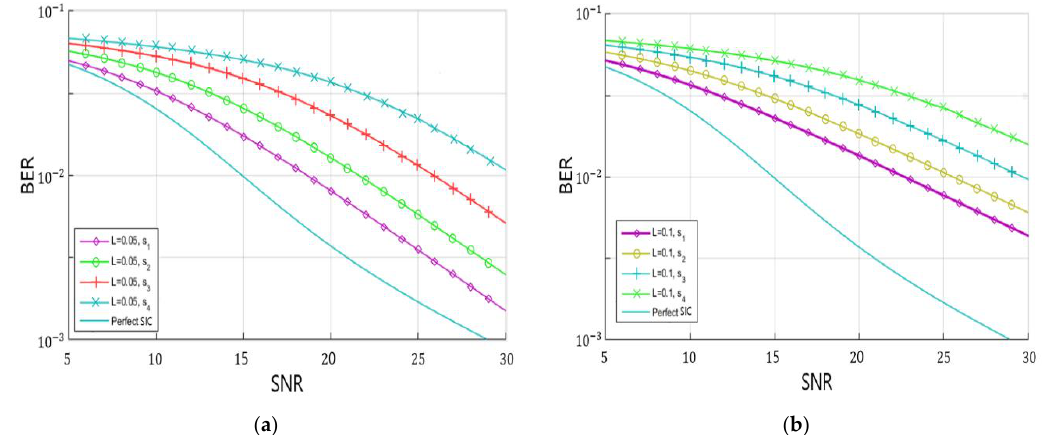
Figure 6. BER versus SNR for the proposed SIC scheme with four users. ( a ) 5% SIC loss, ( b ) 10% SIC loss.